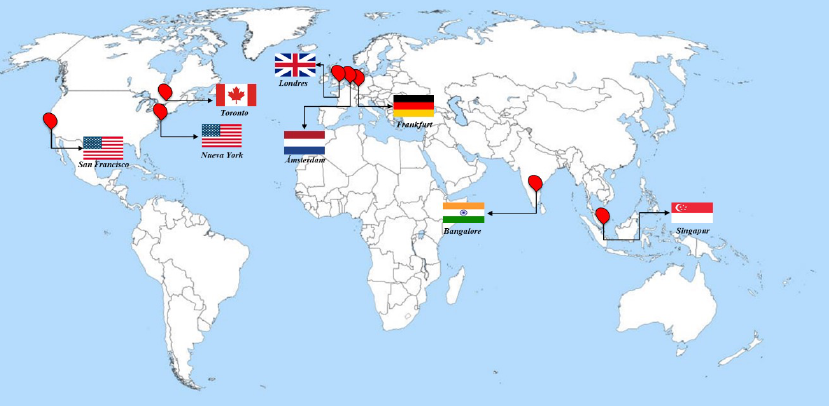
Figure 8. Location of clients available in digital